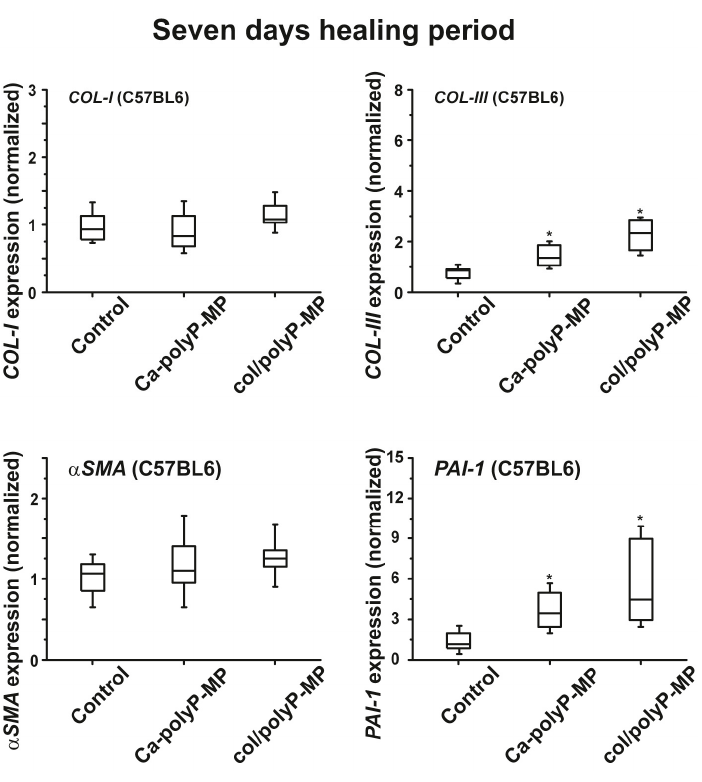
Figure 9. Upregulation of the collagen genes, procollagen type I α ( COL-I ) and collagen type III α I ( COL-III ), in tissue from wild-type animals treated with the microparticles “Ca-polyP-MP” and “col/polyP-MP” (experiment #SP-013-15). The healing period was 7 days. The genes encoding procollagen type I α (COL-I) and α -smooth muscle actin ( α -SMA) remained unchanged. The significance (Box plot characteristics) are given by comparing the values of controls (no polyP added) with the values measured for the “Ca–polyP-MP” and “col/polyP-MP” treated wounds. The horizontal bars within the boxes indicate the median value; * p < 0.005 ( n = 6 animals).